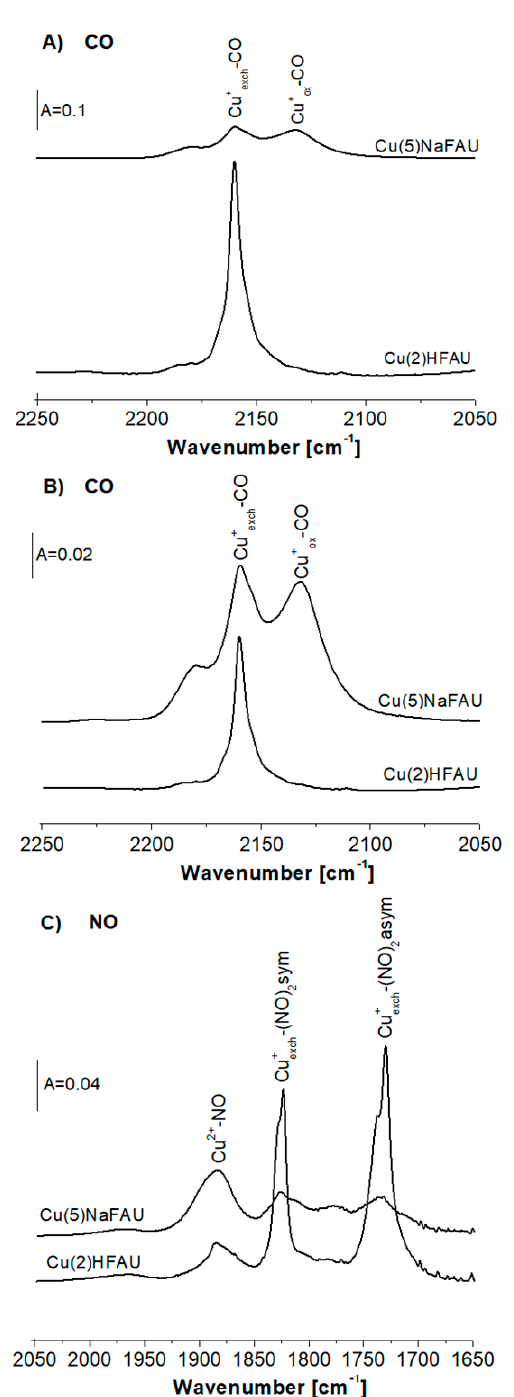
Figure 1. ( A , B ) The infrared (IR) spectra of CO sorbed at room temperature in Cu(2)HFAU and Cu(5)NaFAU zeolites. Spectra are normalized to 10 mg of the sample ( A ) and to the band intensity ( B ). ( C ) The IR spectra of NO sorbed at 190 K on Cu(2)HFAU and Cu(5)NaFAU zeolites.